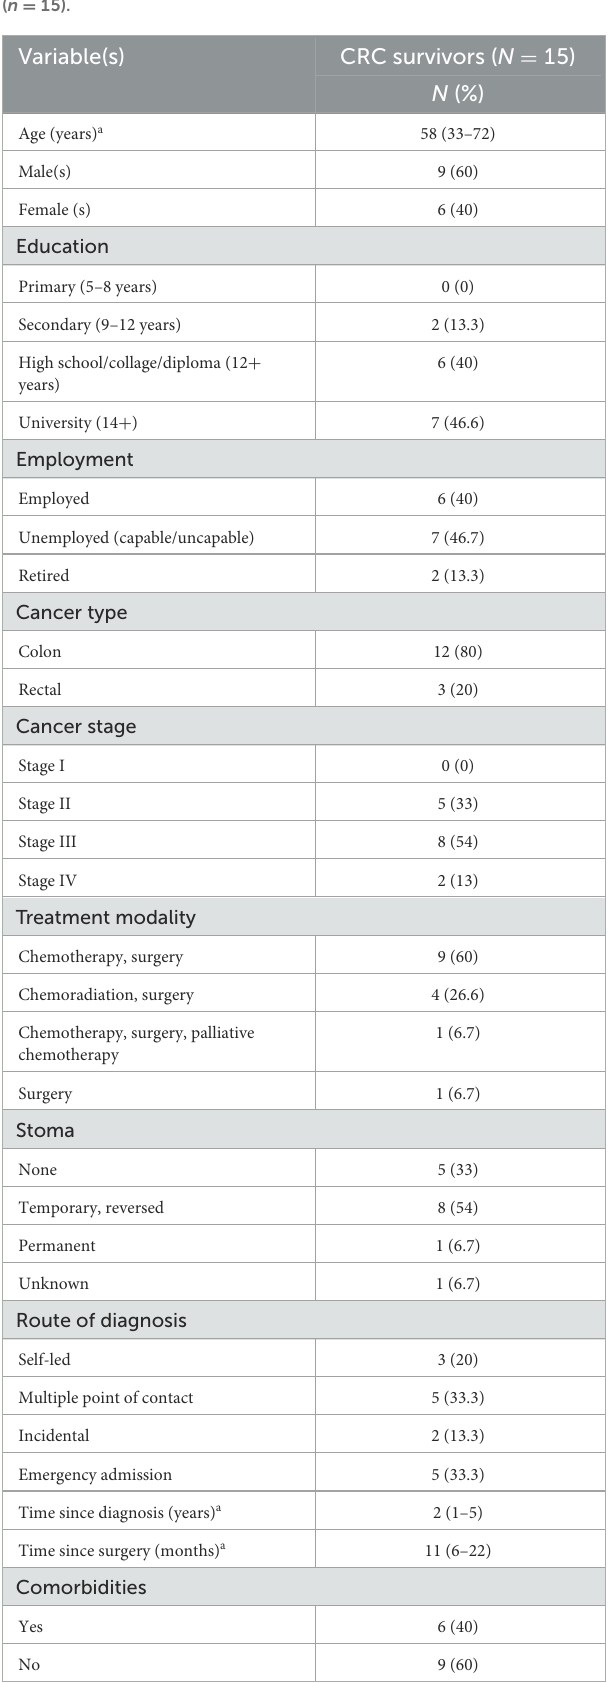
TABLE 3 Characteristics of participants of focus groups ( n =